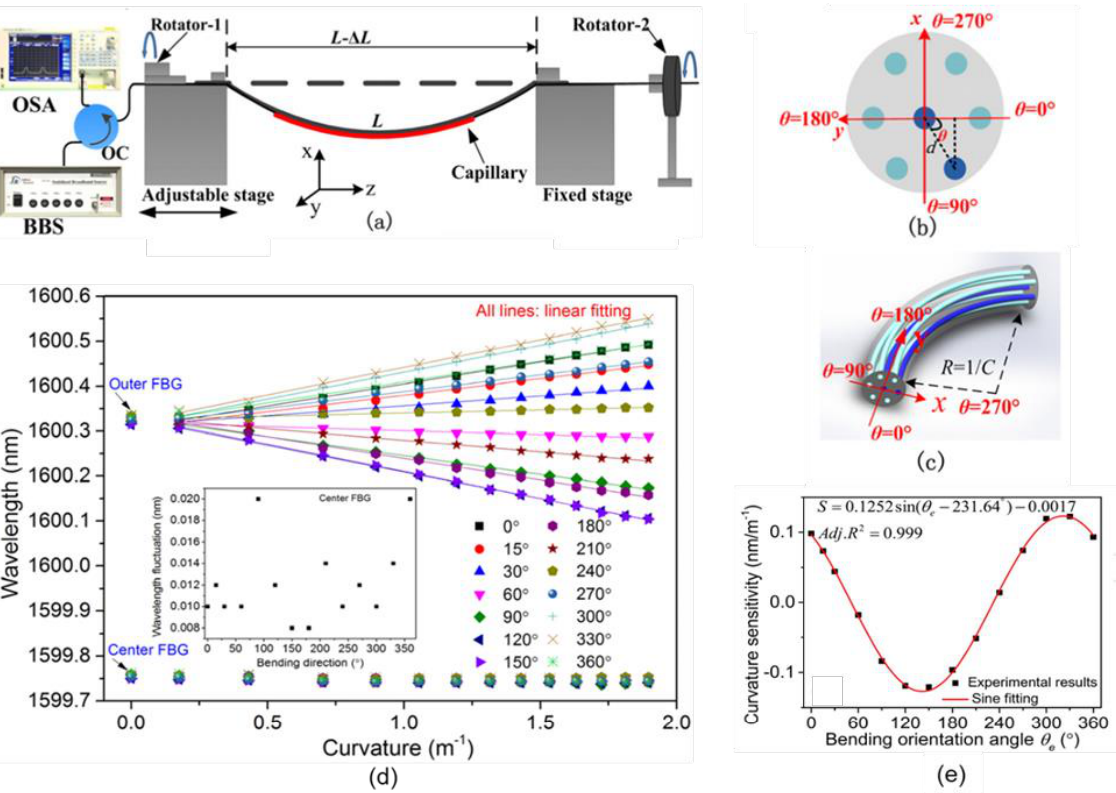
Figure 6. ( a ) Experimental setup of the proposed curvature sensor; ( b ) theoretical definition of the bending orientation angle; ( c ) schematic diagram of a curved fiber when the bending angle is 270°; ( d ) Bragg wavelength shifts versus curvature for the two FBGs at different bending angles. The inset shows the wavelength fluctuations of the central FBG at different bending angles over the curvature range from 0 to 1.896 m − 1 . ( e ) Relationship between the curvature sensitivity of FBG in the off-center core and the experimental bending orientation angle. Adapted with permission from Ref. [39].